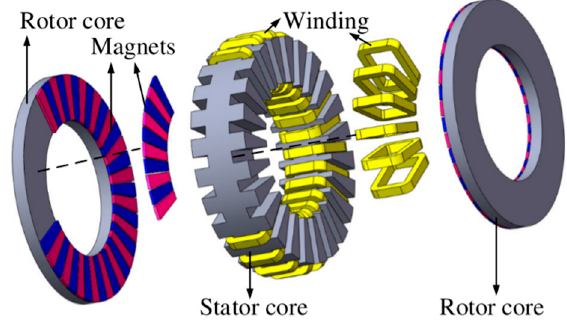
Figure 10. Configuration of an axial-flux SVPM machine [27].